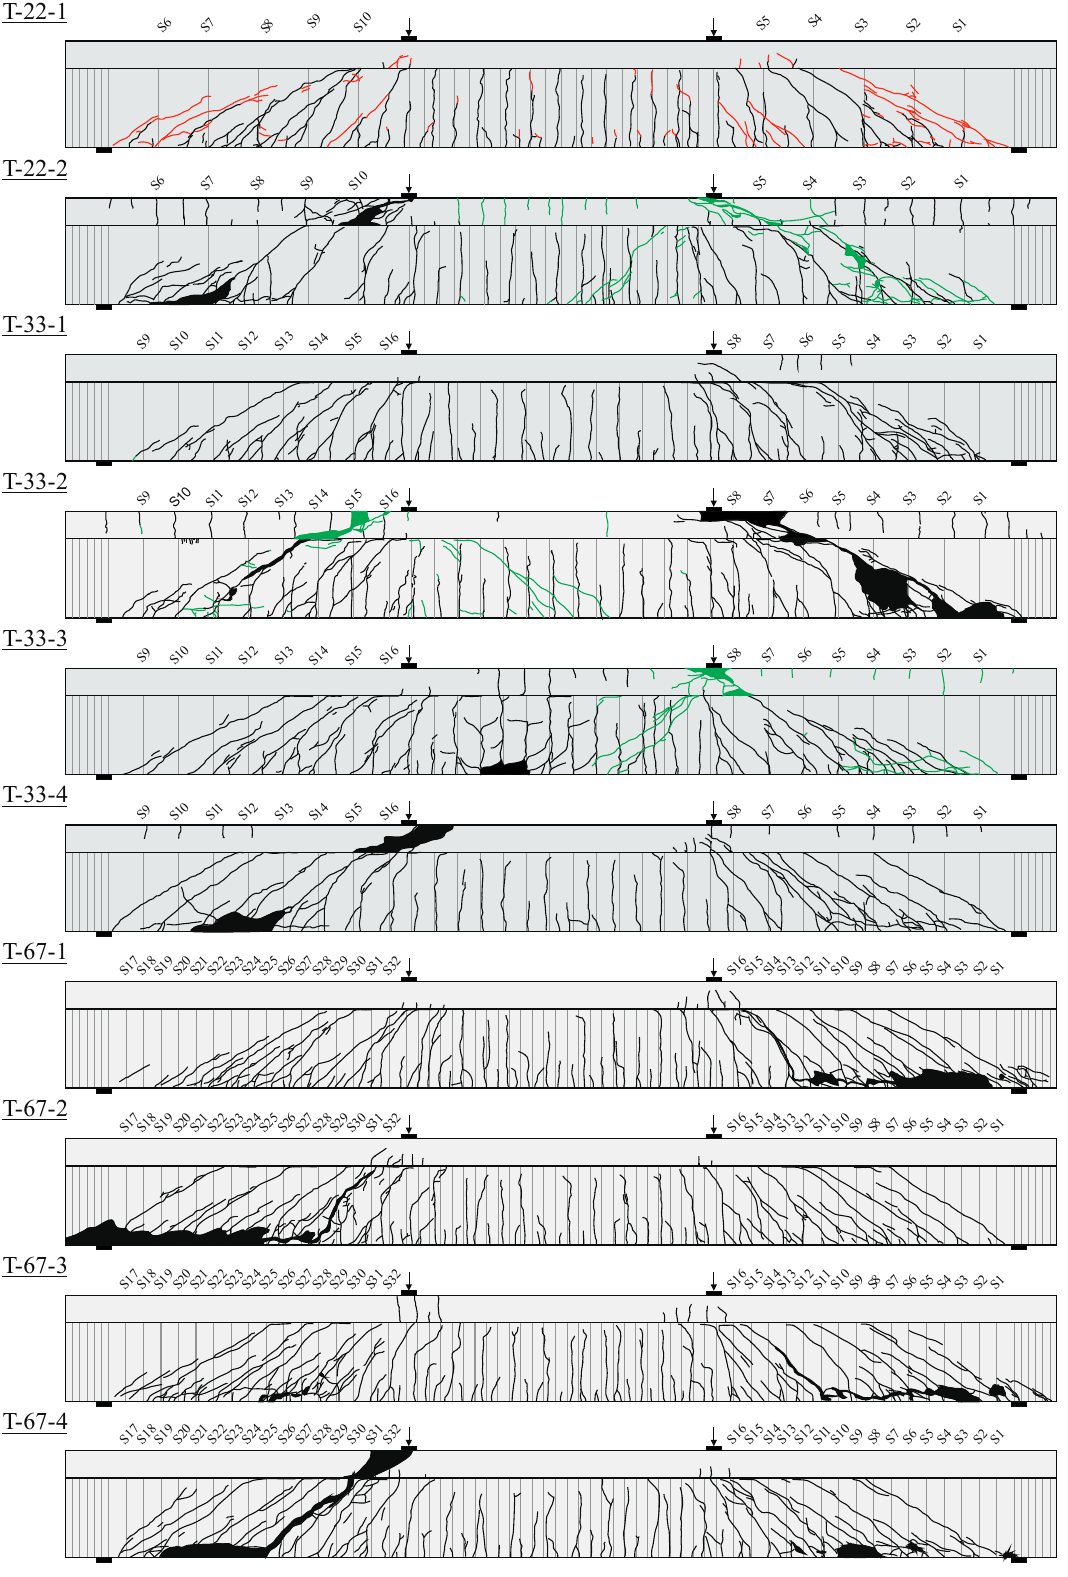
Figure 6. Final crack patterns of all T-Beams (black: cracks at the end of first part; green: cracks at the end of second part; red: cracks from test of residual static shear strength).